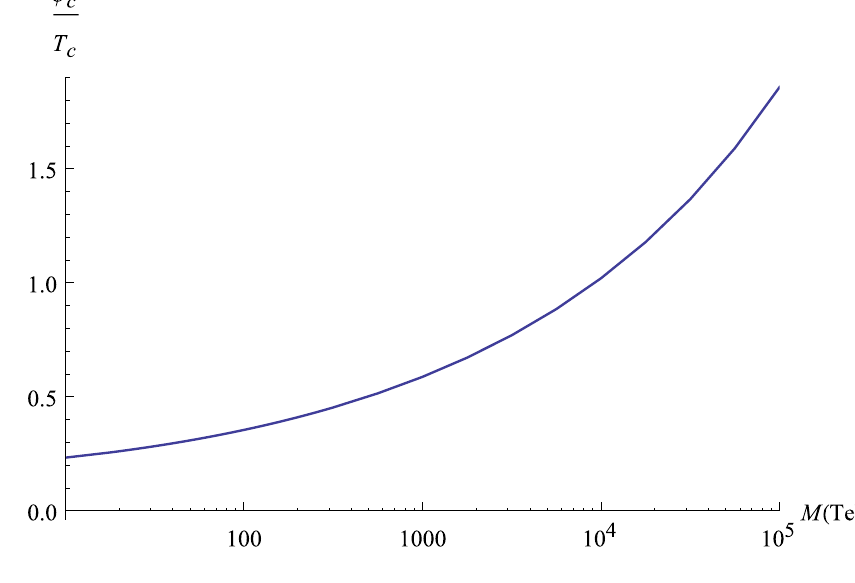
Fig. 1 The strength of the electroweak phase transition as a function of the monopole mass. Monopoles that are at least 9 . 3 · 10 3 TeV in mass can satisfy the sphaleron washout condition and support baryogenesis.This corresponds to a Born–Infeld parameter of β = 1 . 6 · 10 4 ( TeV )